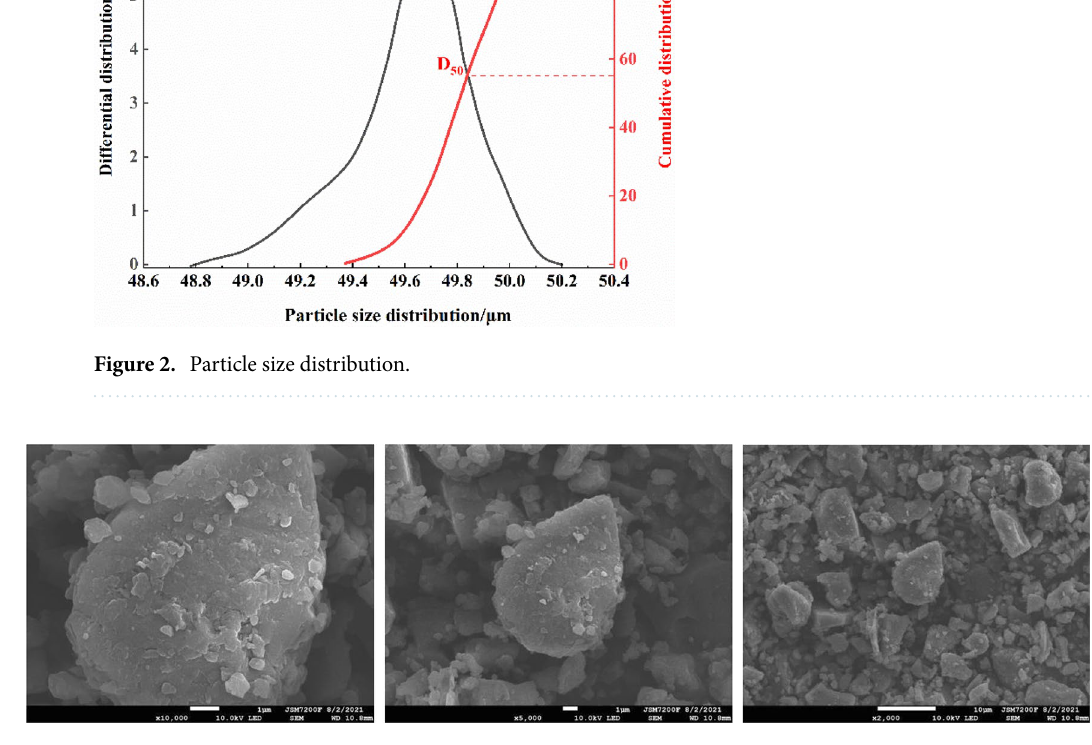
Figure 3. Scanning electron microscope of coal dust